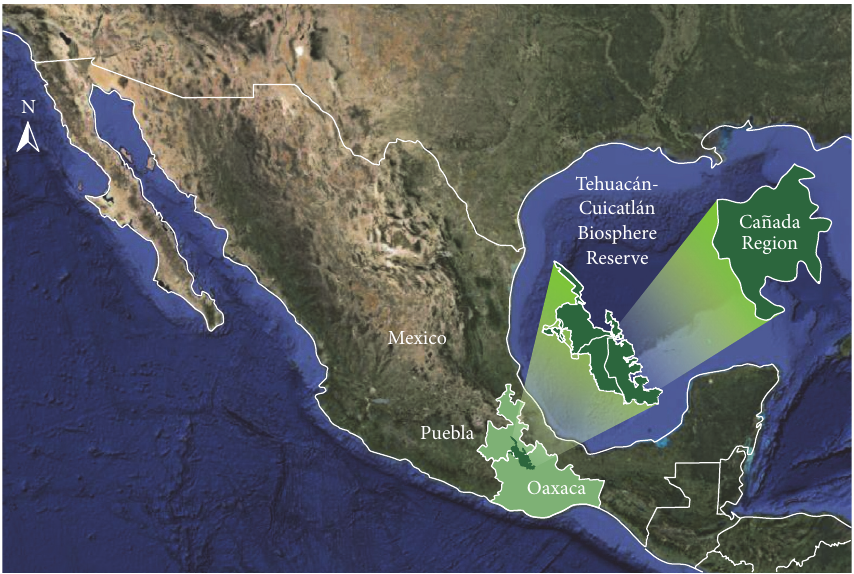
Figure 2: Ca˜nada Region in the State of Oaxaca, Mexico, the only place in the world where chilhuacle chili is produced. Ca˜nada Region is located within the Tehuac´an-Cuicatl´an Biosphere Reserve in southeast Mexico, within the State of Puebla and Oaxaca.